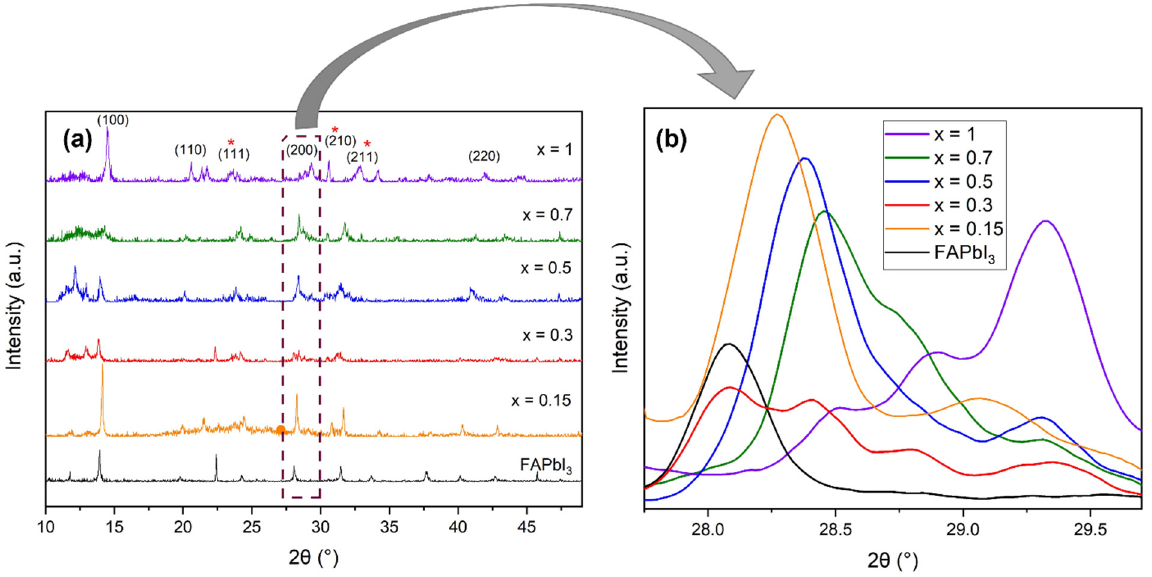
Figure 2. ( a ) XRD patterns of the FAPbI 3 and FA 0.8 Cs 0.2 PbI 3 − x Br x perovskite layers labeled by the concentration of Br used. The red asterisk corresponds to the CsPbBr 3 peaks. ( b ) Zoom-up of the XRD patterns in correspondence of the (200) peak.